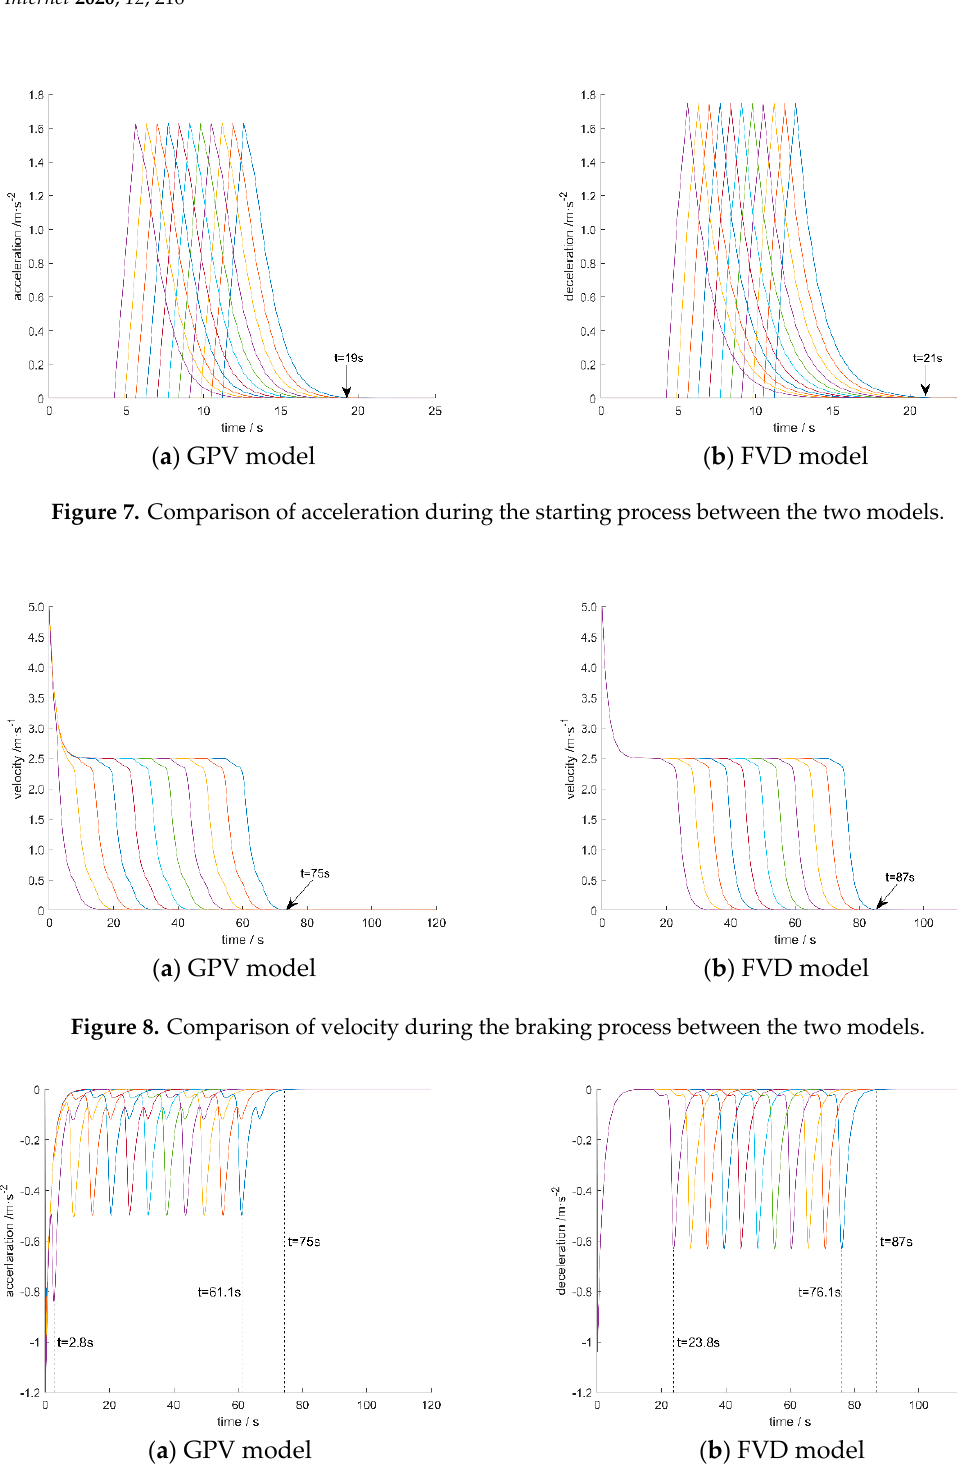
Figure 6. Comparison of velocity during the starting process between the two models.